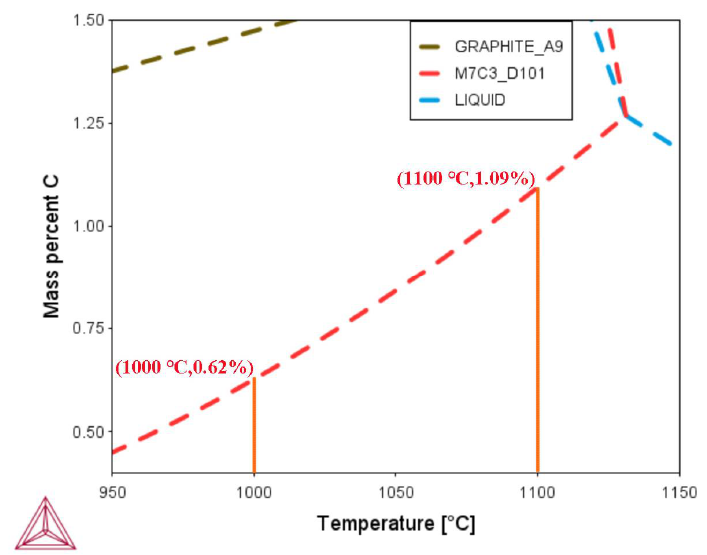
Figure 9. Thermo-Calc phase diagram of C61 steel.